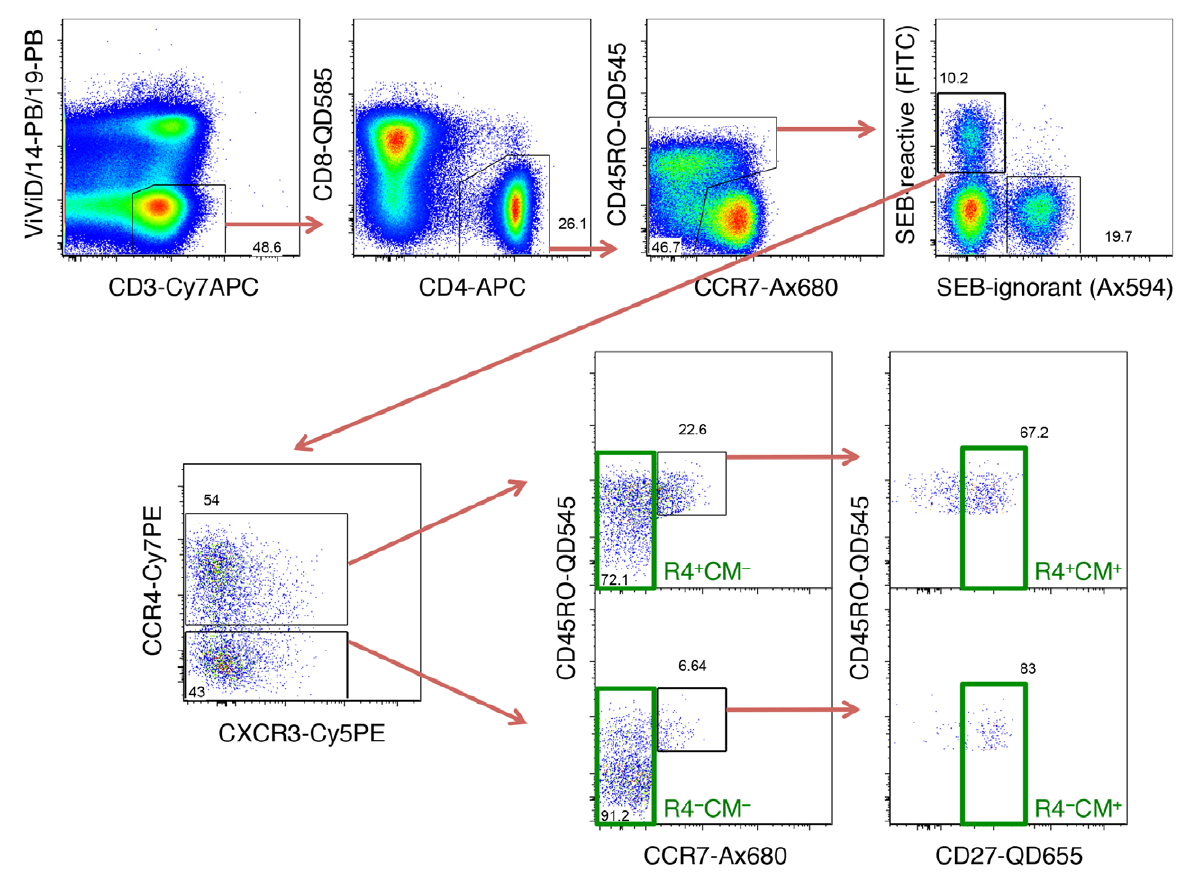
Supplementary Figure 4. T-cell subsets sorted for gene expression analysis. PBMC were stimulated with SEB for 3 hours, before sorting seven CD4 + T-cell subsets from SEB-reactive cells as indicated in this gating scheme. After identifying live CD3 + cells within singlet, aggregate-negative lymphocytes, non-naive CD4 + T cells were selected by excluding CD45RO − CCR7 + cells. Within these, T cells expressing TCR- Vβ12, -Vβ14 or -Vβ17 are known to react to SEB, so FITC-conjugated Abs were used for these three TCR-Vβ chains. Within such SEB-reactive cells, CCR4 + and CCR4− cells were selected and individually − subsets. Further, total SEB-reactive CD4 + T cells, as well gated for T (CD45RO + CCR7 + CD27 + ) or T CM CM as stringently gated Th - (CCR4 − , CCR6 − , CCR10 − , CXCR3 + ) and Th -like cells (CCR4 + CCR6 − CCR10 − 1 2 CXCR3 − ) were also